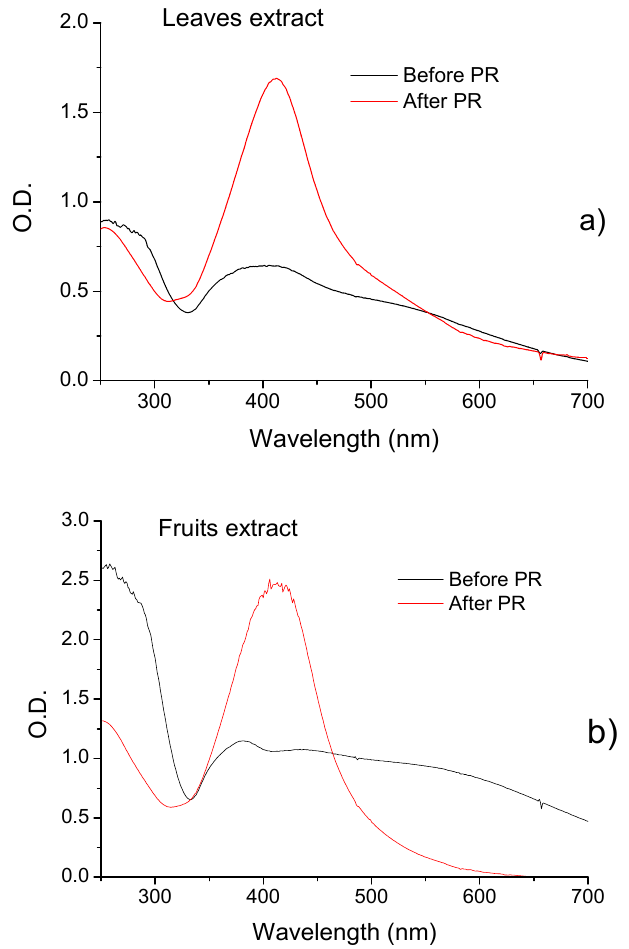
Figure 4. UV-vis spectra of PgAgNPs before and after the photoreduction and pH adjustment for nanoparticles prepared with ( a ) Leaf extract, ( b ) Fruit extract. TEM image of PcAgNPs.